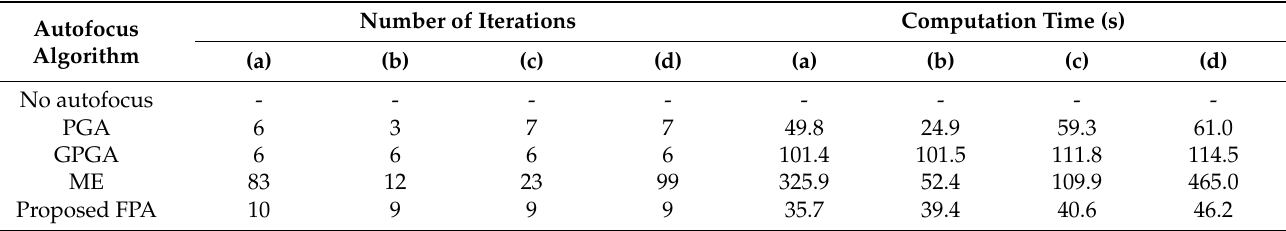
Table 5. Comparison of the number of iterations and computation time for different autofocus algorithms for scene A.